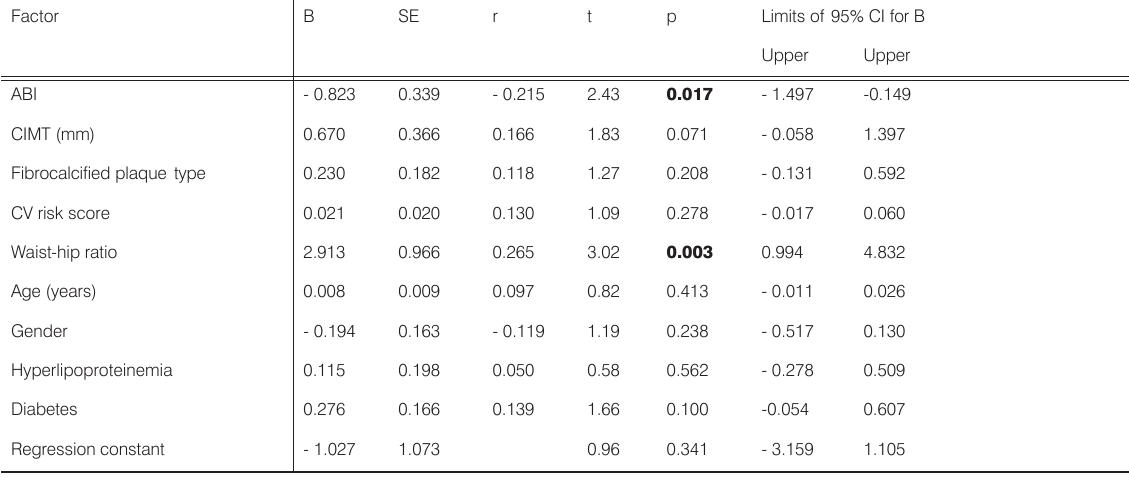
Table 4. Evaluation of the association of investigated parameters and the number of affected coronary blood vessels with the control for impacts of age, gender, hyperlipoproteinemia, and diabetes Factor